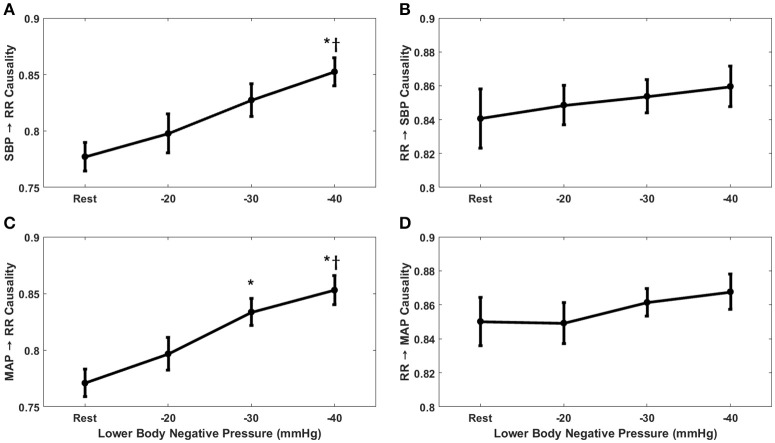
The response of baroreflex (A,C) and non-baroreflex (B,D) causalities to graded lower-body negative pressure. In response to LBNP, MAP→RR (p = 0.004) causality increased significantly at −30 mmHg compared to rest, SBP→RR (p = 0.001) causality increased significantly at −40 mmHg compared to rest. Compared to −20 mmHg the SBP→RR (p = 0.04) and MAP→RR (p = 0.01) causality increased significantly at −40 mmHg LBNP. No change in RR→SBP (p = 0.76) and RR→MAP (p = 0.60) causality was observed in response to LBNP. *Represents significant difference (p < 0.05, post-hoc result) from rest while †represents significant difference from −20 mmHg.